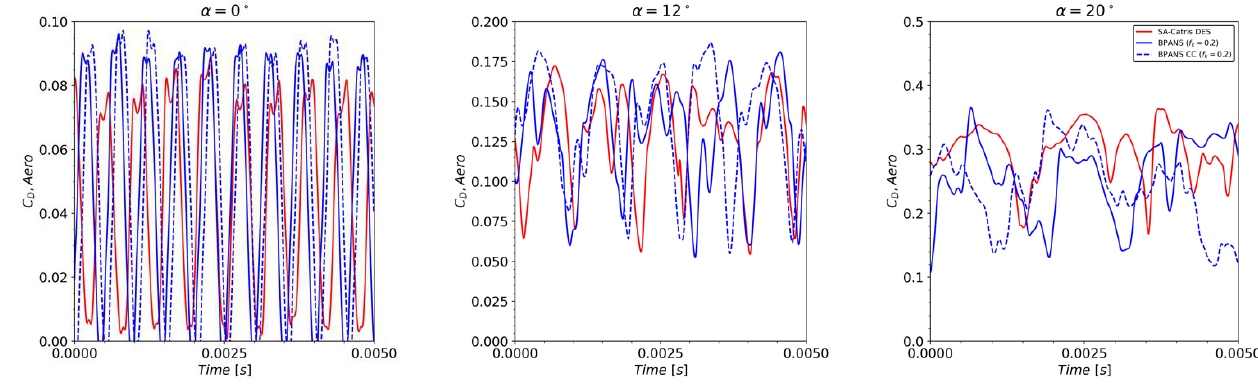
Figure 8. Aerodynamic drag versus time for the different angles of attack.